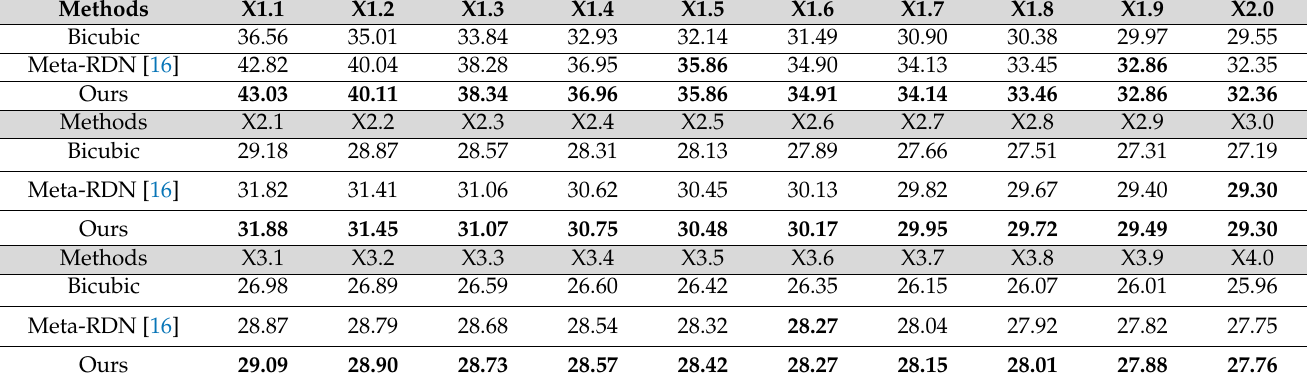
Table 2. PSNR (dB) performance evaluation on the proposed convolution weight prediction method using the B100 dataset [19]. The best performance is highlighted in the bold